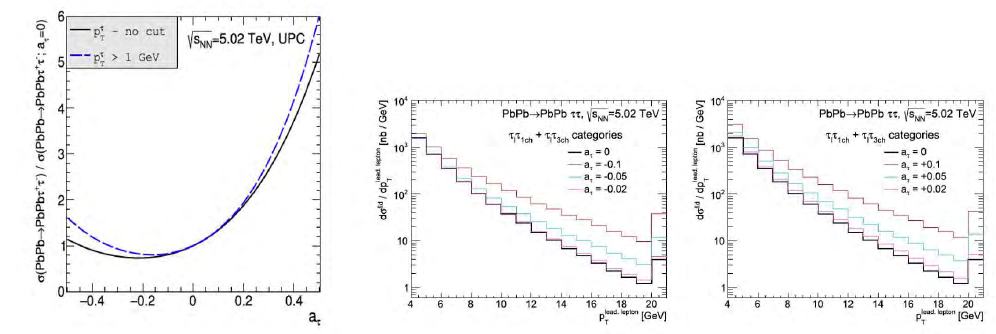
Figure 3. τ -pair cross-section dependence on a τ (normalised to a τ = 0) (left), and τ - p T distribution as a function of positive (central) and negative (right) a τ